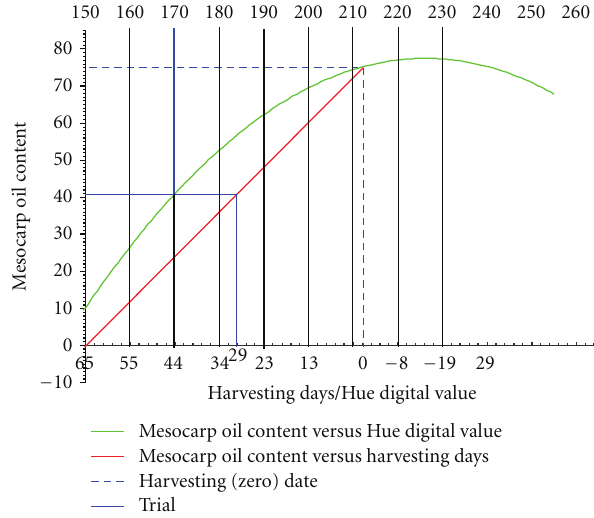
Figure 14: The graph for determining the day of harvesting the FFB.